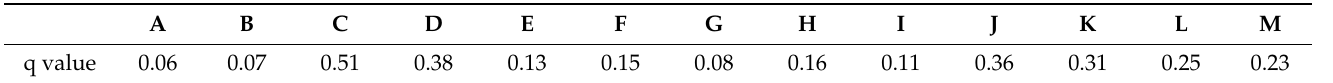
Table 1. Analysis of influencing factors of the spatial distribution of ethnic minority villages in Fujian Province.